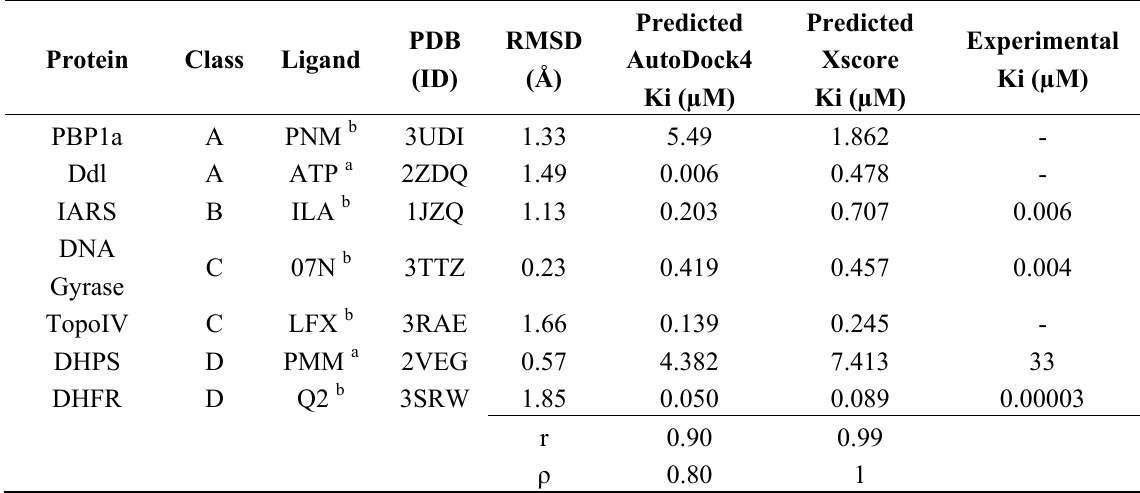
Table 1. Values of Ki predicted by AutoDock4, Xscores and experimental values of